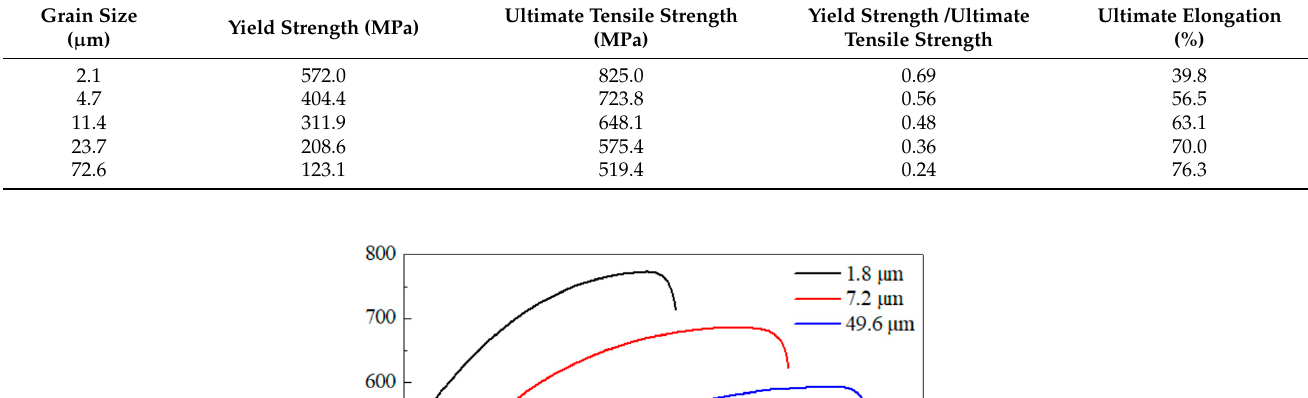
Table 2. Tensile properties of Fe–31Mn–3Al–3Si steel with different grain sizes (Reprinted with permission from Ref. [21] Copyright 2022 Elsevier).